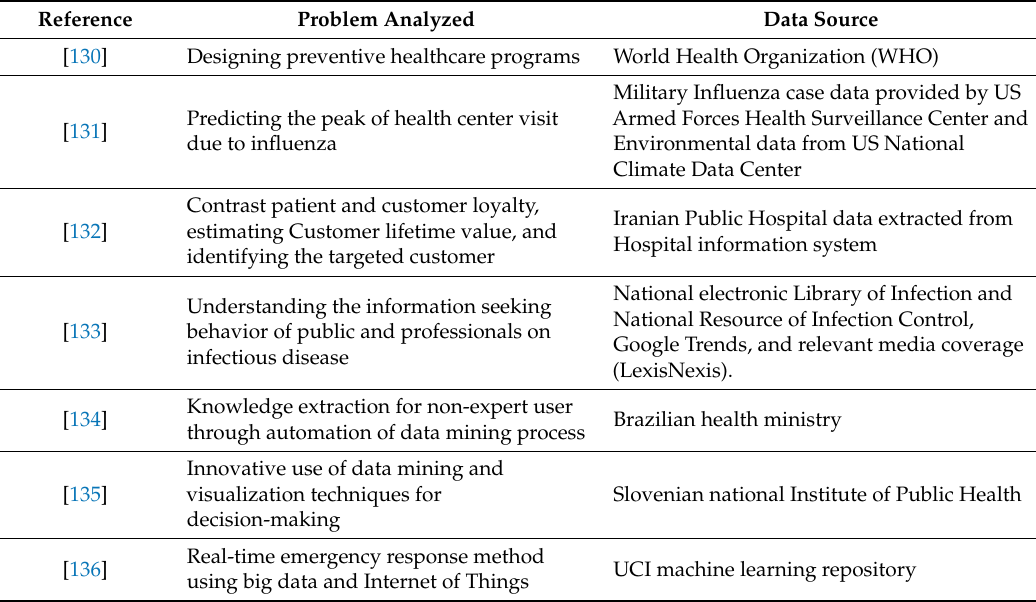
Table 9. List of data mining application in public health with data